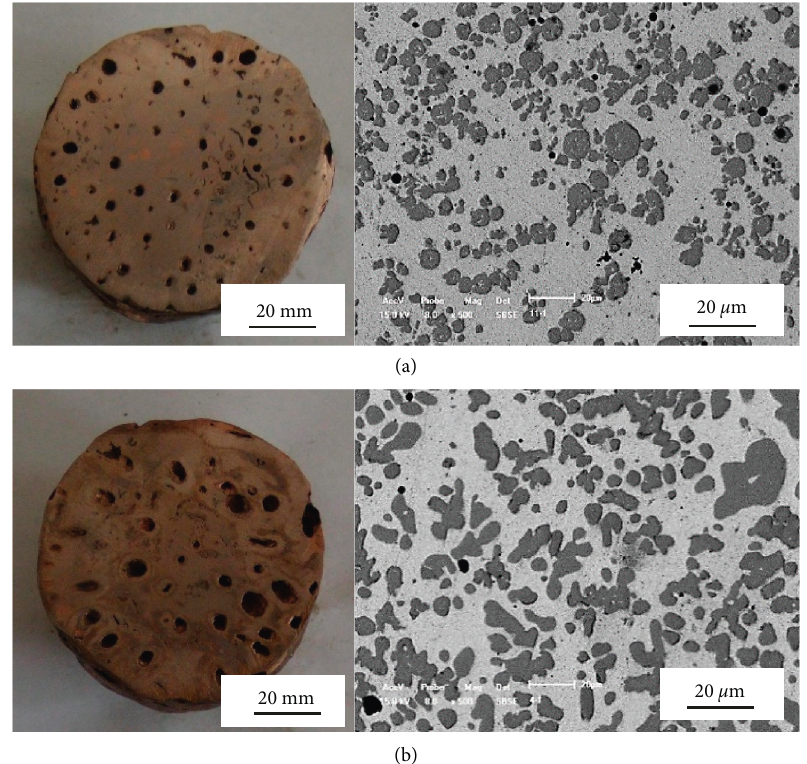
Figure 24: Macroscopic and microscopic photographs of Cu-Cr alloy ingots prepared by aluminothermic reduction under magnetic field stirring [75, 76]. (a) CuCr25. (b) CuCr50 (magnification 500 times).